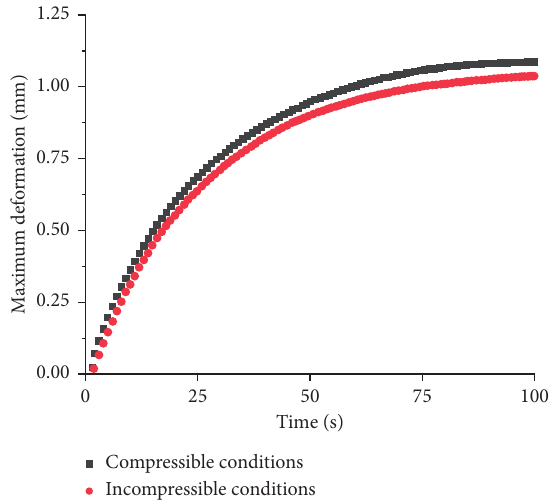
Figure 7: Effect of gas density on deformation of thermowell with time.